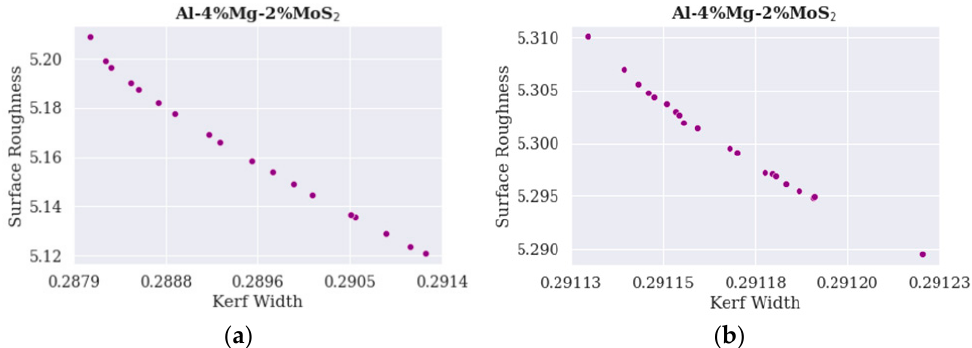
Figure 6. Pareto optimal solutions for Al-4%Mg-2%MoS 2 by ( a ) NSGA-II, and ( b ) MOPSO. For Al-4%Mg-2%MoS 2 , Pareto-optimal solutions are obtained at 10 A of peak current, 50 µs of pulse on time, and 30 – 33 V of gap voltage. For Al-4%Mg-4%MoS 2 sample, Figure 7a,b shows the Pareto optimal solutions obtained by NSGA-II an MOPSO